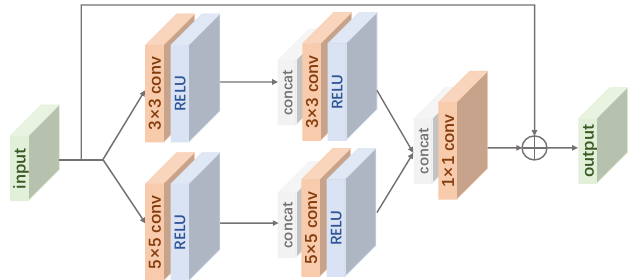
Figure 6. The structure of multi-scale residual block (MSRB) [65].